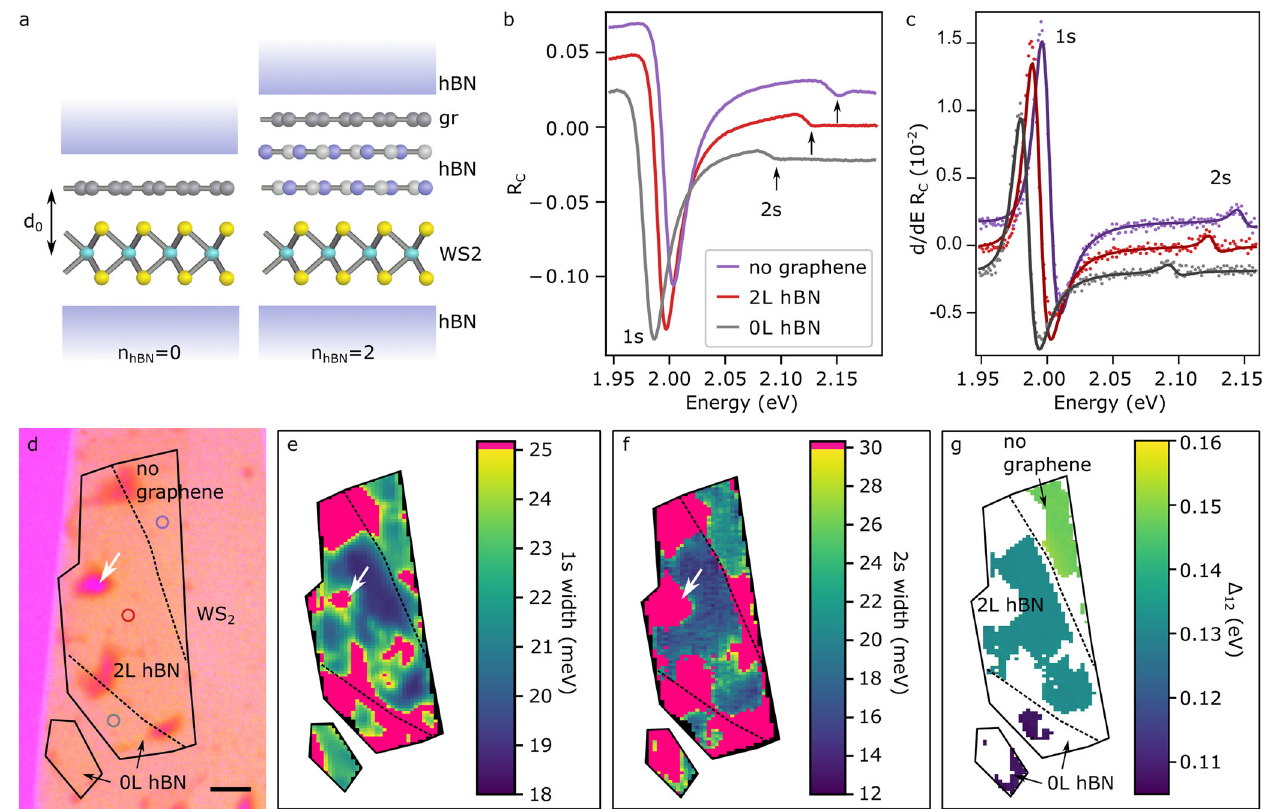
Fig. 1 Sample structure and optical measurements. a Sketch of the 2D heterostructure, consisting of hBN-encapsulated WS 2 and graphene monolayers, separated by n hBN layers of hBN. b Three typical spectra taken at sample areas with 0 and 2 spacer layers as well as an area with no graphene (positions shown in ( d )). The curves are offset vertically for clarity. c Derivative of the spectra (circles) shown in panel ( b ) and their respective fi ts (lines), offset for clarity. d Optical microscope image of a typical sample. The black outline denotes the area of WS 2 , while the black dotted lines separate areas of different hBN spacer layer thicknesses. Scalebar: 2 μ m. e , f Falsecolor maps of the 1s and 2s exciton linewidth of the sample shown in panel ( d ). g Map of the 1s-2s exciton level spacing Δ 12 of the same sample. Areas of increased 1s or 2s linewidths are